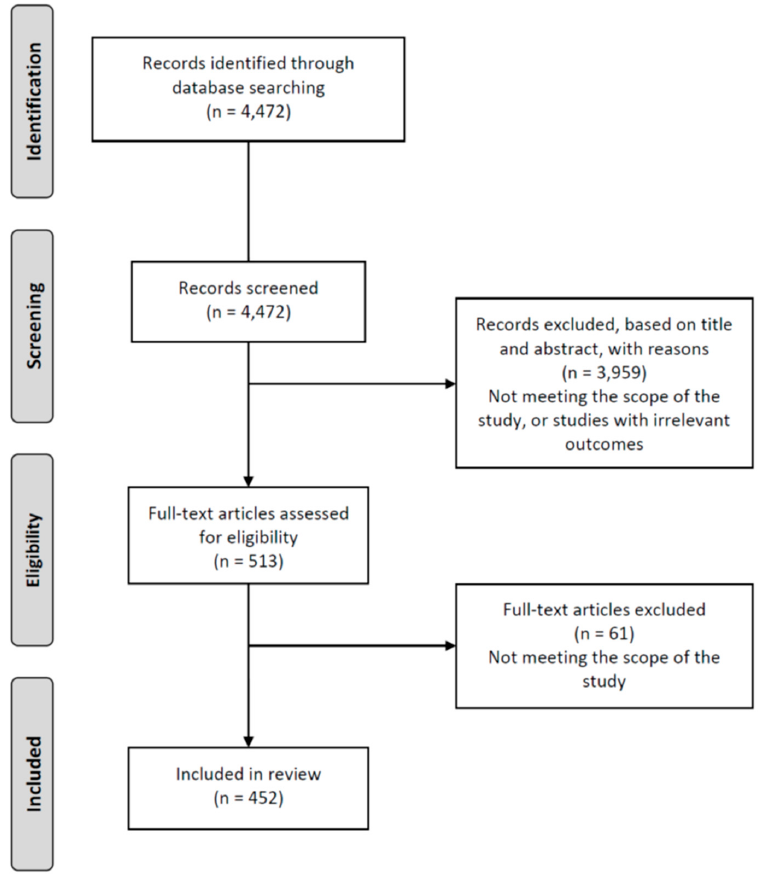
Figure A1. PRISMA flow diagram of the literature search, eligibility and selection procedure.